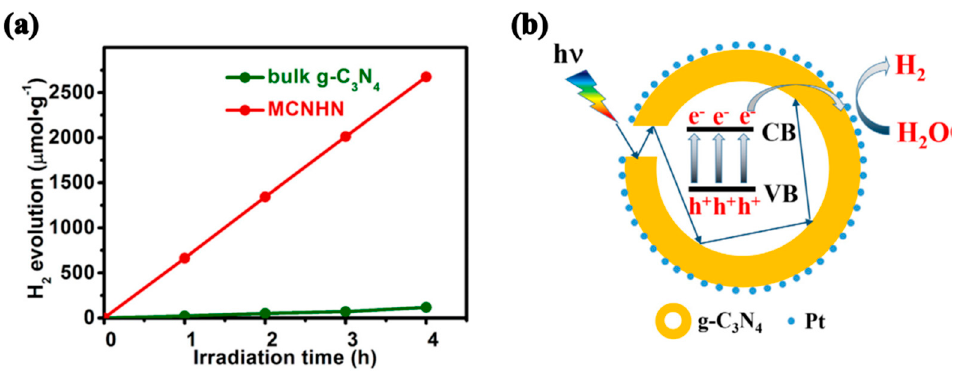
Figure 5. ( a ) Time course of H 2 evolution and ( b ) a schematic mechanism for photocatalytic H 2 evolution on MCNHN. Reproduced with permission from [62]; copyright (2018), Elsevier.